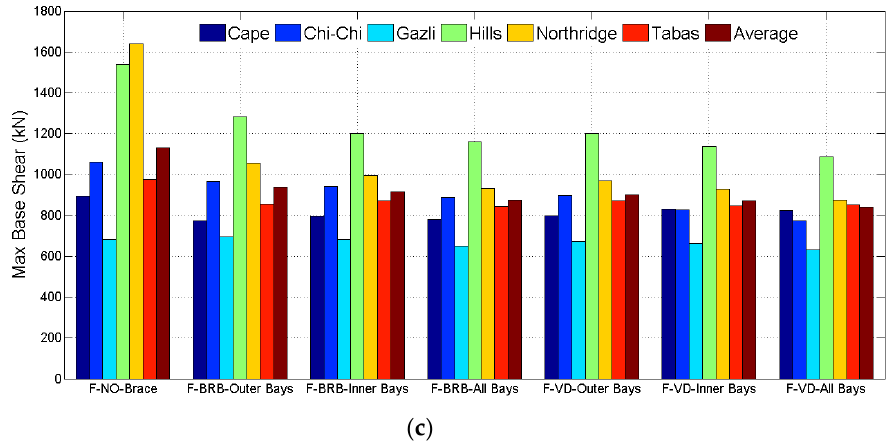
Figure 15. Maximum base shear in ( a ) 4-, ( b ) 8-, and ( c ) 12-story frames.